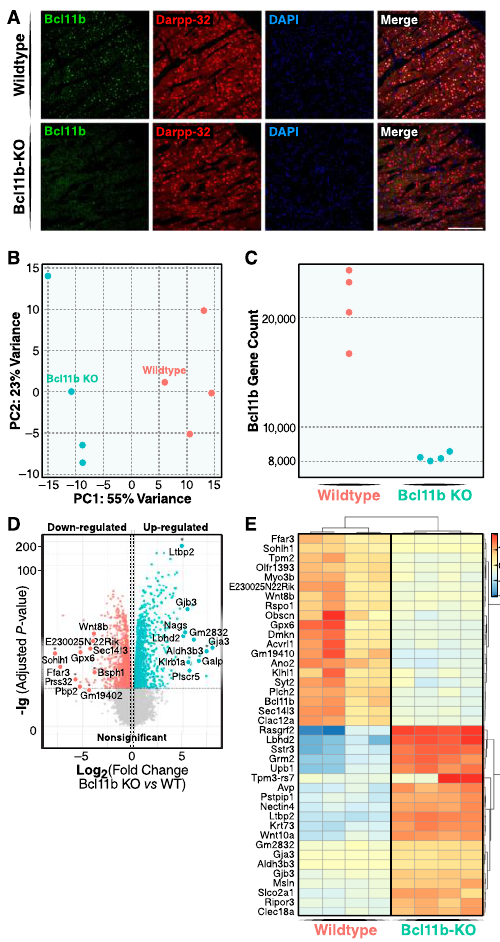
Figure 1. Identification of transcriptome portraits of Bcl11b deletion and WT cells by RNA-seq analysis in Cre+ and Cre − MSNs populations from the striata of D9-Cre mice. ( A ) D9-Cre- Bcl11b tm1.1Leid mice specifically knocked down expression Bcl11b in MSNs by using a D9- Cre under the control of regulatory elements of the mouse Ppp1r1b gene-encoding DARPP-32. D9-Cre-Bcl11b tm1.1Leid and Cre -negative mice (4-months-old) were analyzed using immunohistochemistry (IHC) with a BCL11B antibody. Scale bar is 500 mm. ( B ) PCA plots using the rlog-transformed values indicate a significant difference in the transcriptome Bcl11b deleting MSNs, and controls. ( C ) Scatter plot shows that Bcl11b gene expression is much less in D9-Cre-Bcl11b tm1.1Leid mice than Cre – control mice. ( D ) Volcano plot shows differences in Cre + and Cre − gene expression. Genes with an adjusted p -value below 0.01 with absolute log2 fold ratio greater than 1 are highlighted. Genes in red are relatively decreased in expression in the Cre − population (i.e., enriched in the WT population), those in green are relatively increased in expression in the Bcl11b tm1.1Leid mice, and those in grey are equally distributed among the two populations. ( E ) Heatmap of relative normalized count values across samples. Top 20 up- and downregulated genes that have the highest product of log fold-change and base mean are reported, respectively. Top downregulated genes include: Bcl11b , free fatty acid receptor ( Ffar3 ), spermatogenesis and oogenesis-specific basic helix-loop-helix 1 ( Sohlh1 ), beta tropomyosin ( Tmp2 ), myosin IIIB ( Myo3b ), wnt family member 8B ( Wnt8b ), R-spondin-1 ( Rspo1 ), Obscurin ( Obscn ), glutathione peroxidase 6 ( Gpx6 ), dermokine ( Dmkn ), serine/threonine-protein ki- nase receptor, R3, activin A receptor-like type 1 ( Acvrl1 ), anoctamin-2 ( Ano2 ), kelch-like protein 1 ( Klhl1 ), synaptotagmin-2 ( Syt2 ), 1-phosphatidylinositol 4,5-bisphosphate phosphodiesterase eta-2 ( Plch2 ), Sec14l3 (uncharacterized protein), and C-type lectin domain family 12 member A (Clec12a).